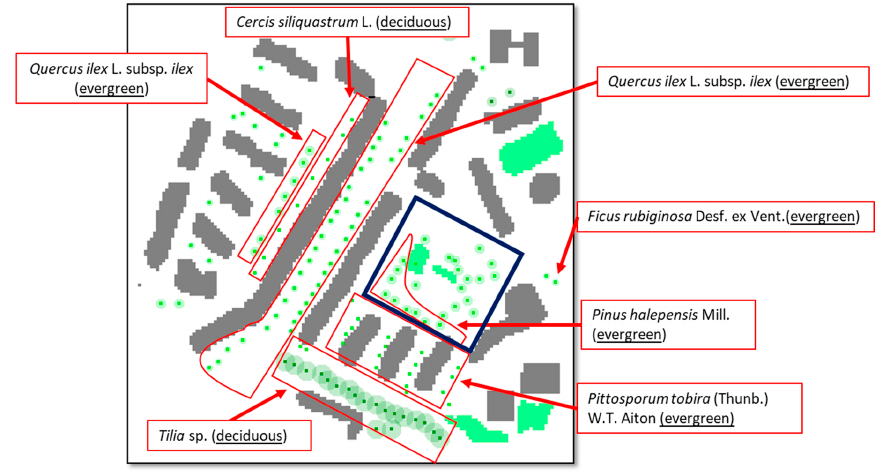
Figure 4. Most abundant plant species present in the Santa Rosa district. The blue rectangle indicates Piazza Santa Rosa. Atmosphere 2020 , 11 , x FOR PEER REVIEW